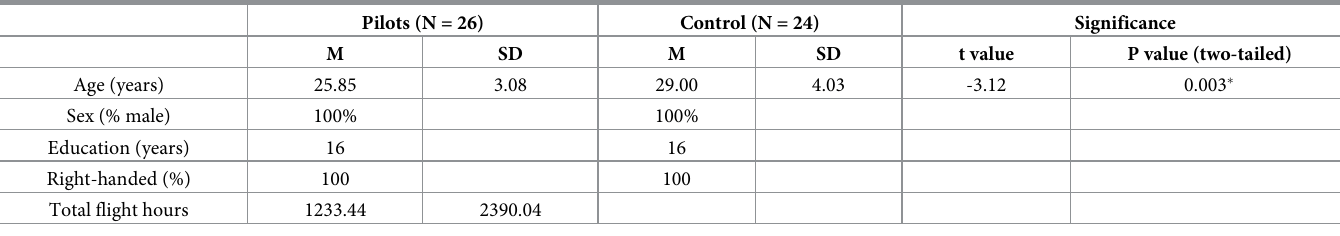
Table 1. Demographic